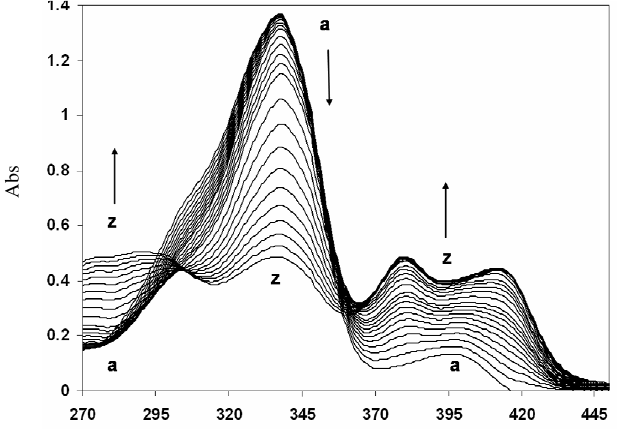
Figure 2. UV-Vis absorption spectral changes for 1.0 mM N,N' -bis(4-dimethyl aminobenzylidene)1,2-diaminoethane (BDAE) with UV irradiation in chloroform. From a to z, each irradiation time = 300 s; total, 4680 s.